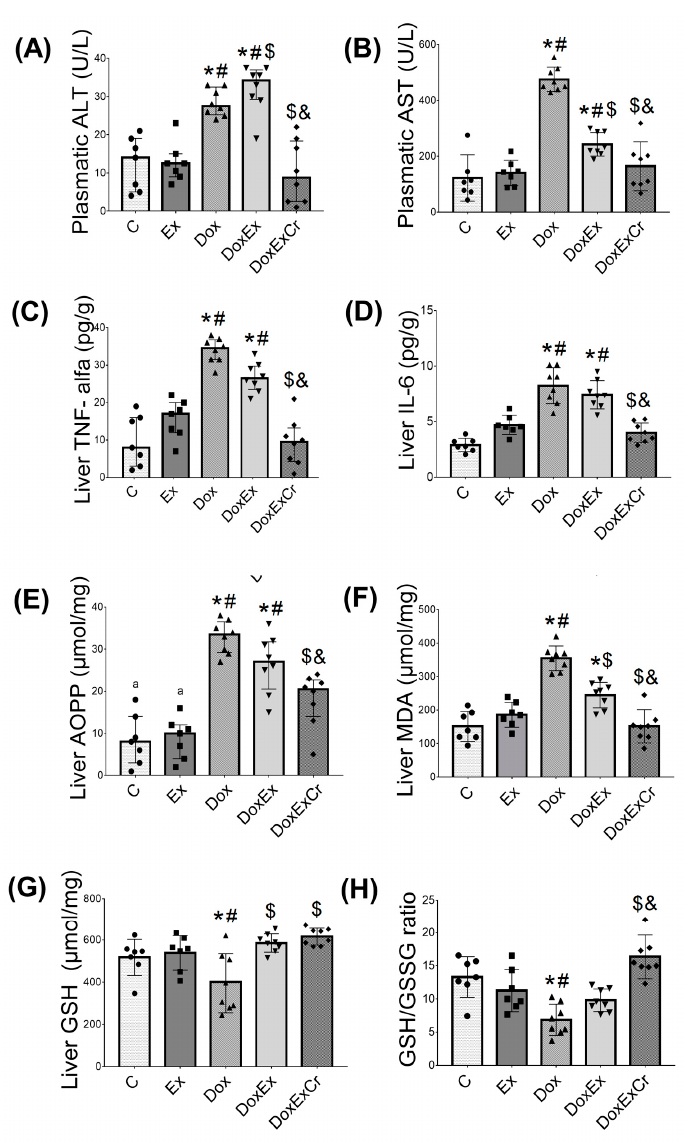
Figure 2. Creatine supplementation associated with ST prevented doxorubicin-induced hepatotoxicity. Plasma concentration of hepatic transaminases, ( A ) ALT and ( B ) AST, hepatic concentration of inflammatory mediators, ( C ) TNF- α and ( D ) IL-6, and oxidative damage and antioxidant defense markers ( E ) AOPP, ( F ), MDA ( G ), and GSH, and ( H ) GSH/GSSG ratio for groups control (C, n = 7), exercised (Ex, n = 7), treated with doxorubicin (Dox, n = 8), treated with doxorubicin and exercised